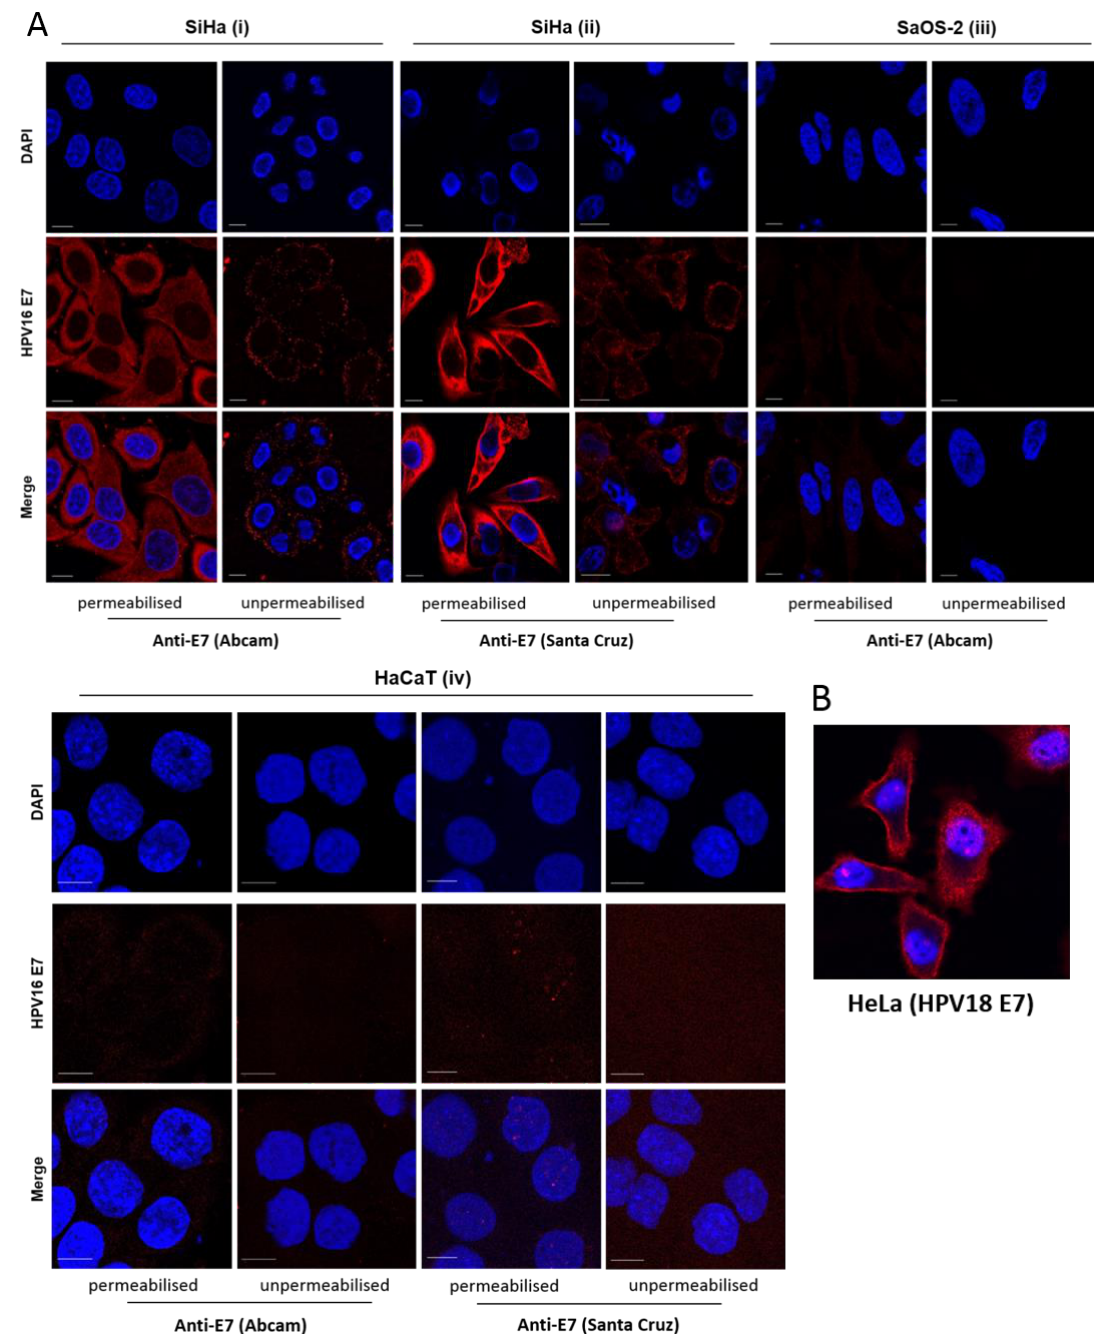
Figure 2. E7 distributes to the plasma membrane of HPV-transformed cells. ( A ) HPV16 E7+ SiHa cells (i and ii) and SaOS-2 cells (iii) HaCaT cells (iv) (as negative controls, containing no E7) were fixed, permeabilised and incubated with antibodies recognising full-length HPV16 E7 (i) and (iii) and residues 35–56 (ii). A comparable group of live cells was incubated with these antibodies in parallel. Cells were fixed and stained with AlexaFluor568 anti-mouse antibodies. Fluorescent imaging was performed using either a Zeiss LSM700 or LSM510 inverted microscope. The scale bar = 10 µm. Representative images are shown; ( B ) HeLa cells were fixed, permeabilised and labelled with anti-HPV18 E7 antibodies, which recognise residues 36–70, followed by staining with AlexaFluor594 goat anti-mouse IgG.